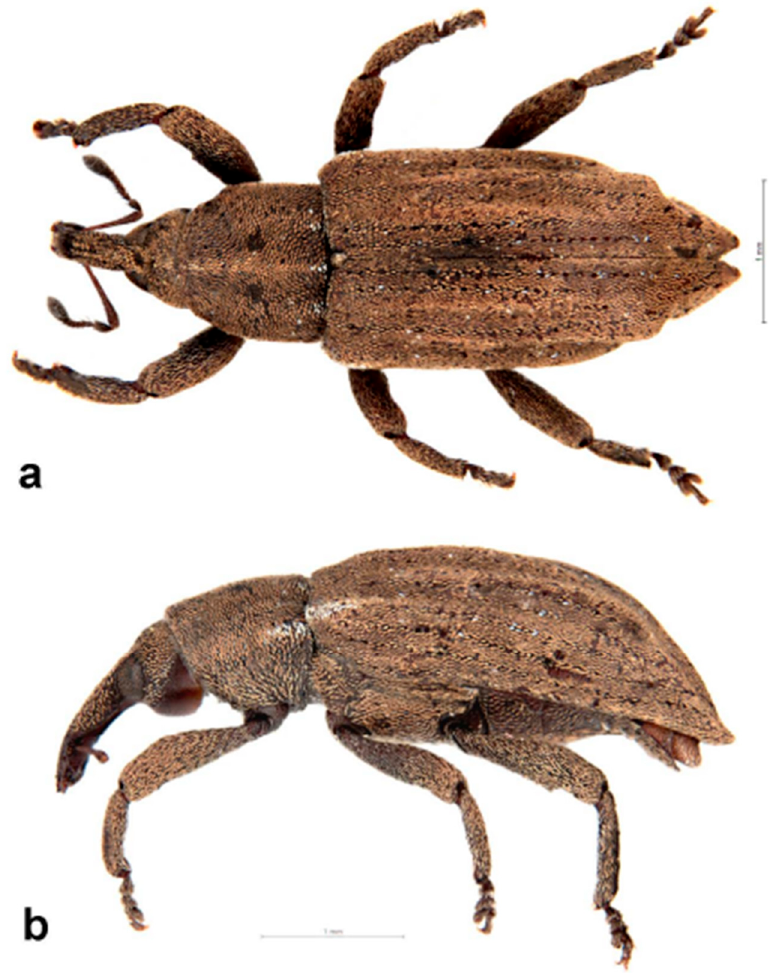
Figure 18. Imbilius araucariae : ( a ) habitus of male, dorsal aspect; ( b ) habitus of male, lateral aspect.